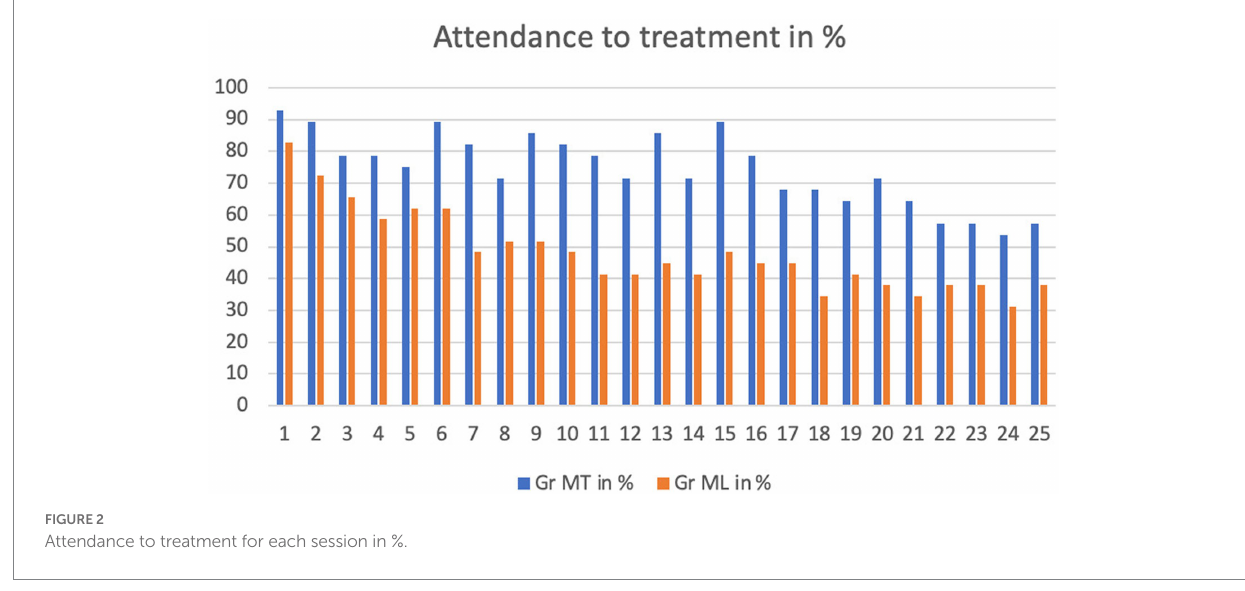
FIGURE 2 Attendance to treatment for each session in %.